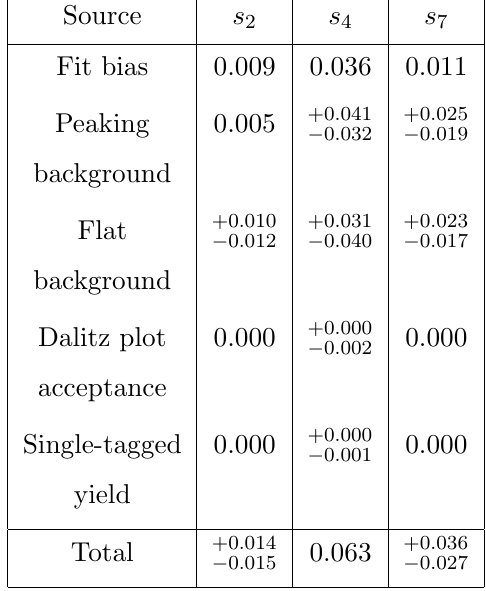
Table 8 . Systematic uncertainties on s i values.